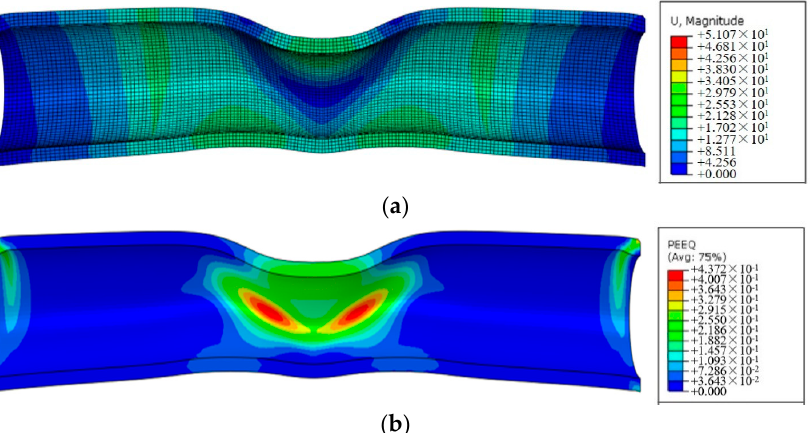
Figure 10. Simulation results when the elastic modulus of cement sheath is 9 Gpa: ( a ) displacement; ( b ) equivalent plastic strain.